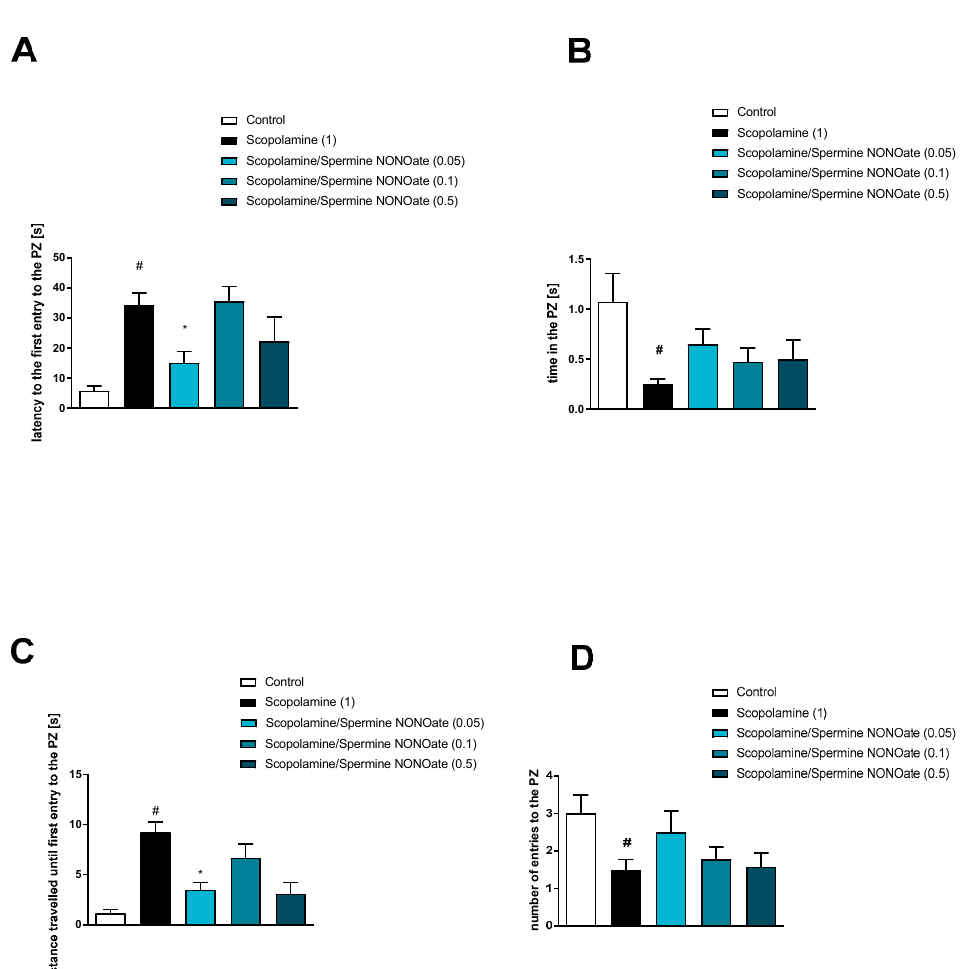
Figure 11. The effects of spermine NONOate on scopolamine-induced deficits in the retention of spatial memory in the MWM of CD1 mice. PZ-related parameters. ( A ) the latency to the first entry to the PZ, ( B ) the time in the PZ, ( C ) the distance travelled in the PZ, ( D ) the number of entries into the PZ. The following values are expressed as means ± SEM. # p < 0.001 vs. control group * p < 0.05 vs. scopolamine-treated animals (N = 8–10).